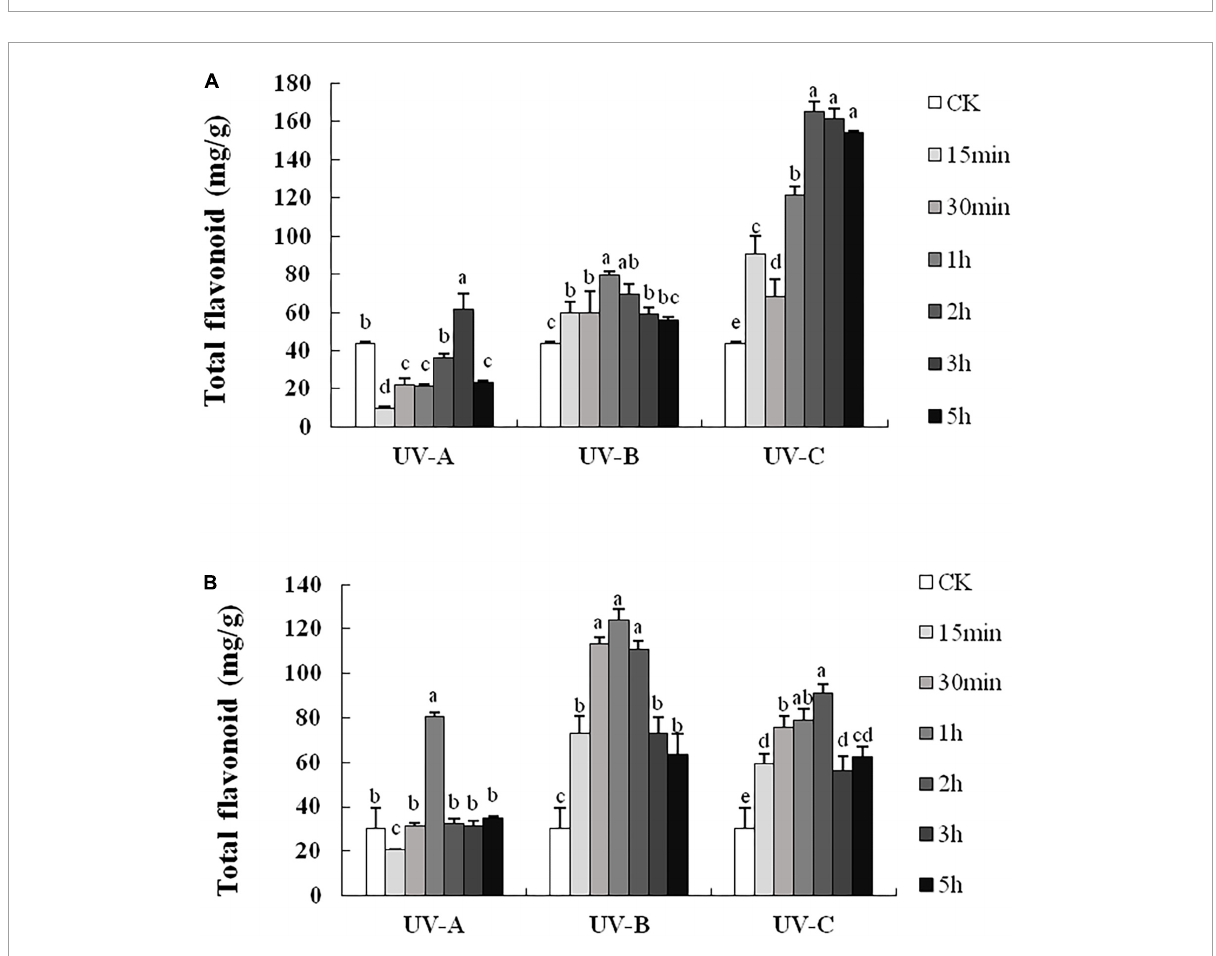
FIGURE2 Total flavonoid contents in leaves (A) and root tubers (B) of Tetrastigma hemsleyanum with UV-A, UV-B, and UV-C treatments. Different lowercase letters indicate significant difference at 0.05 level ( P < 0.05).